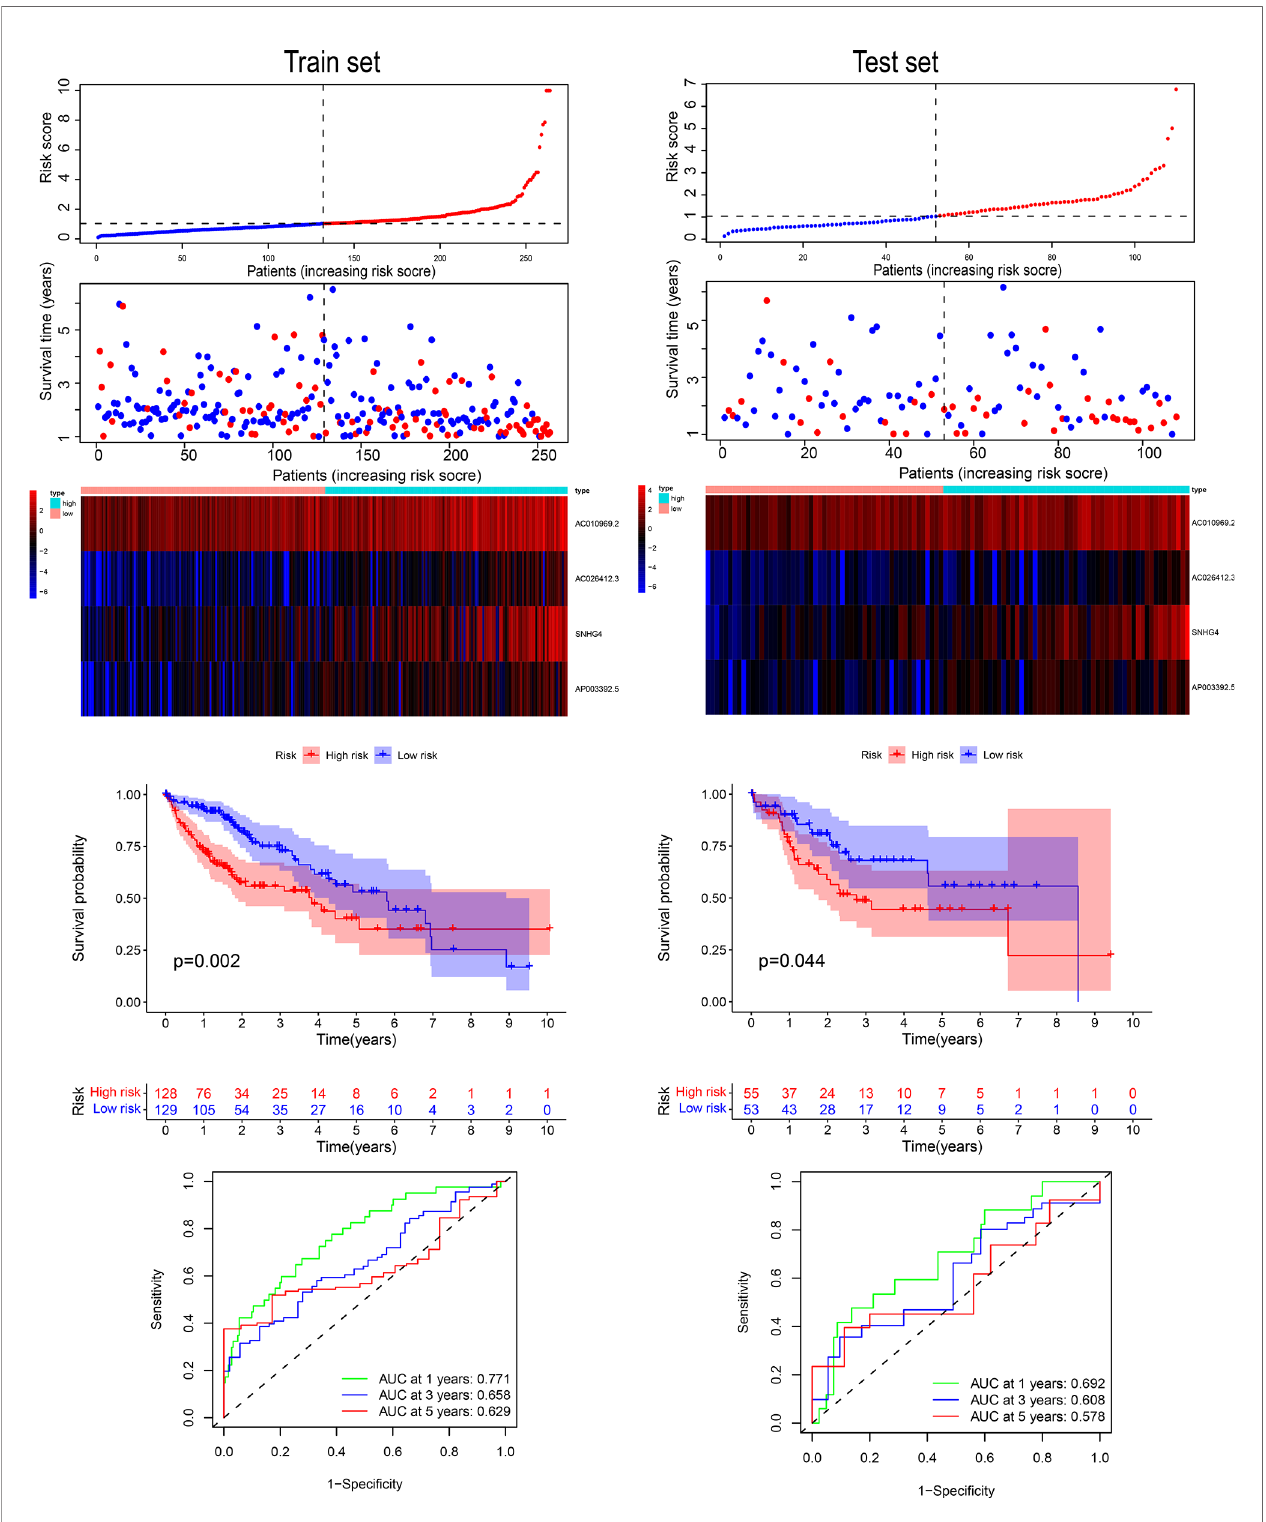
FIGURE 5 | The four-gene signature ’ s risk score distribution and survival status in the training and validation sets. ROC curves of 1, 3, and 5 years, and survival curves between the two risk groups based on the four-gene signature classi fi